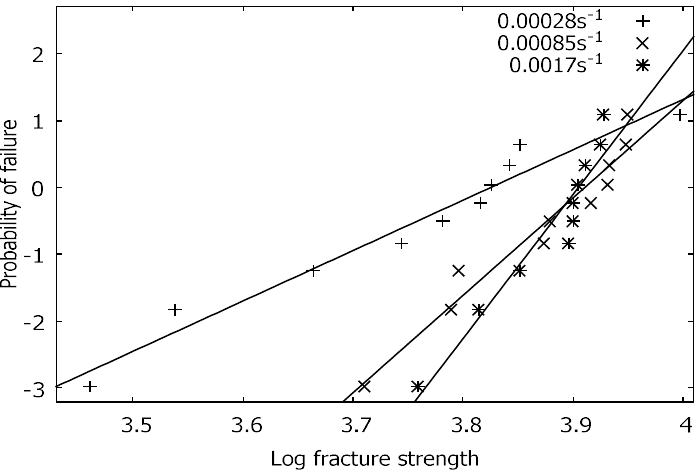
Figure 9. Weibull probability plot of 212 µm bagasse-reinforced composites at different strain rates.